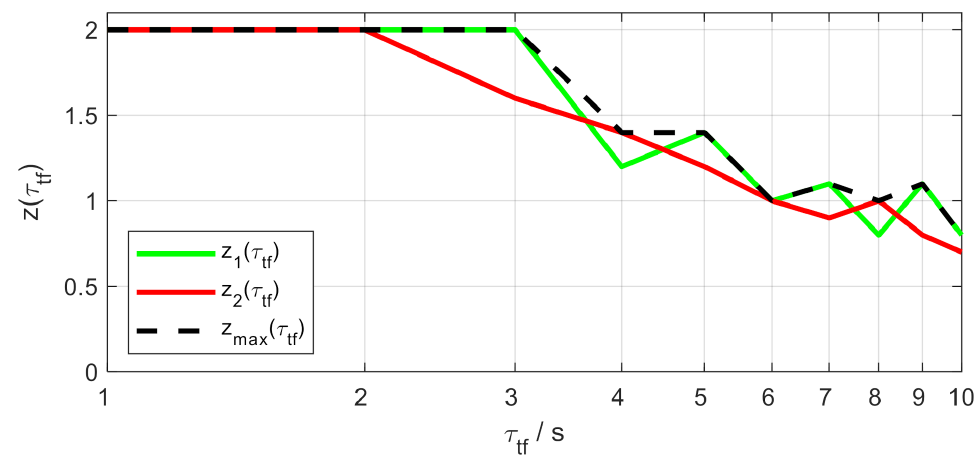
Figure 5. Exemplary time-weighted continuous load curves. Modified from [9], Technische Univer- sität Dresden,